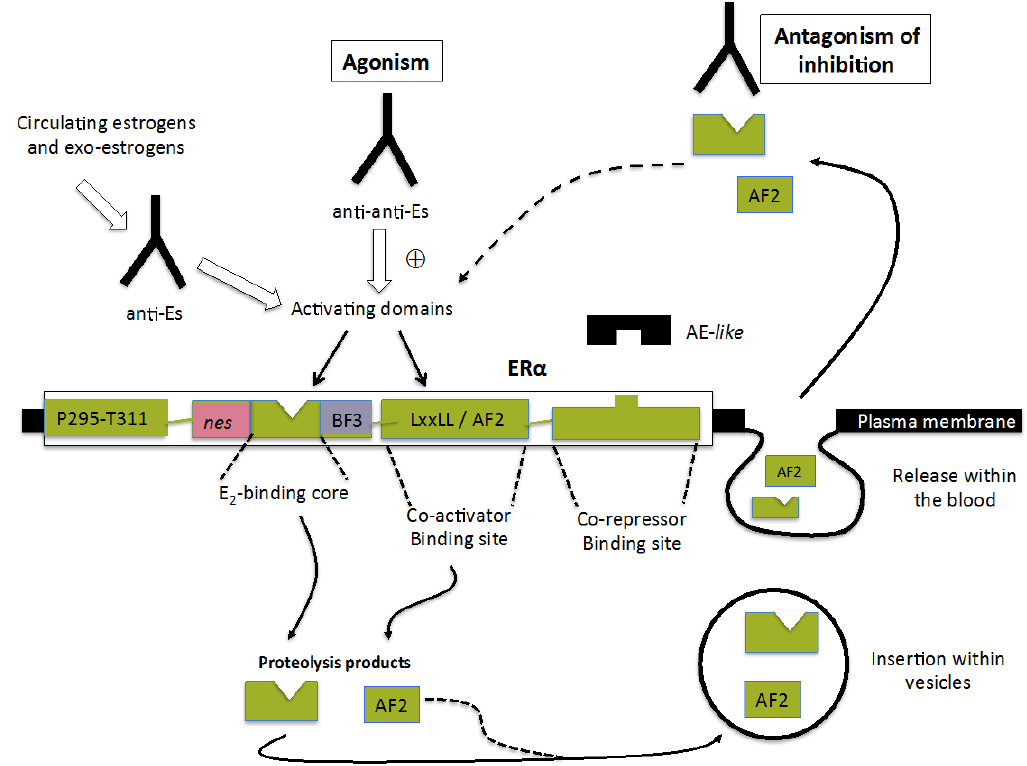
Figure 3. Schematic representation of suspected mechanisms able to contribute to ER α ABs’ emergence. Agonists: antibodies able to mimic the action of circulating estrogens (natural, synthetic and xenoestrogens). Anti-antagonists: antibodies against a natural extra-cellular repressor recognizing a specific inhibitory site of ER α or preventing the access of activating modulators to the receptor by a competitive binding process. ER α degradation products including binding sites for estrogens or LXXLL motifs of co-activators [24], released within the blood, may generate this last class of antibodies. Es: Estrogens, BF3: Binding function 3, AF2: Activation function 2.